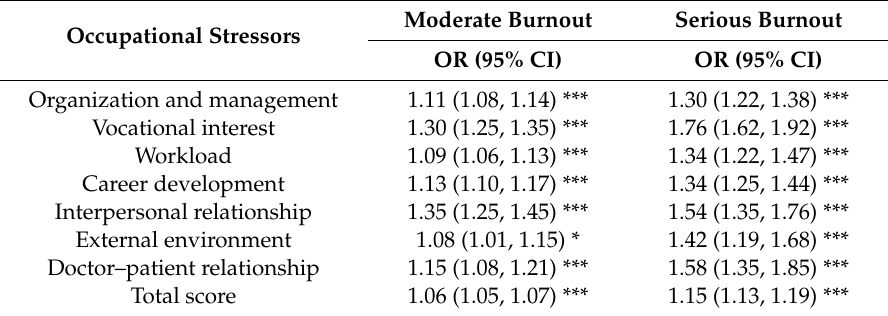
Table 3. The associations between di ff erent domains of occupational stressors and